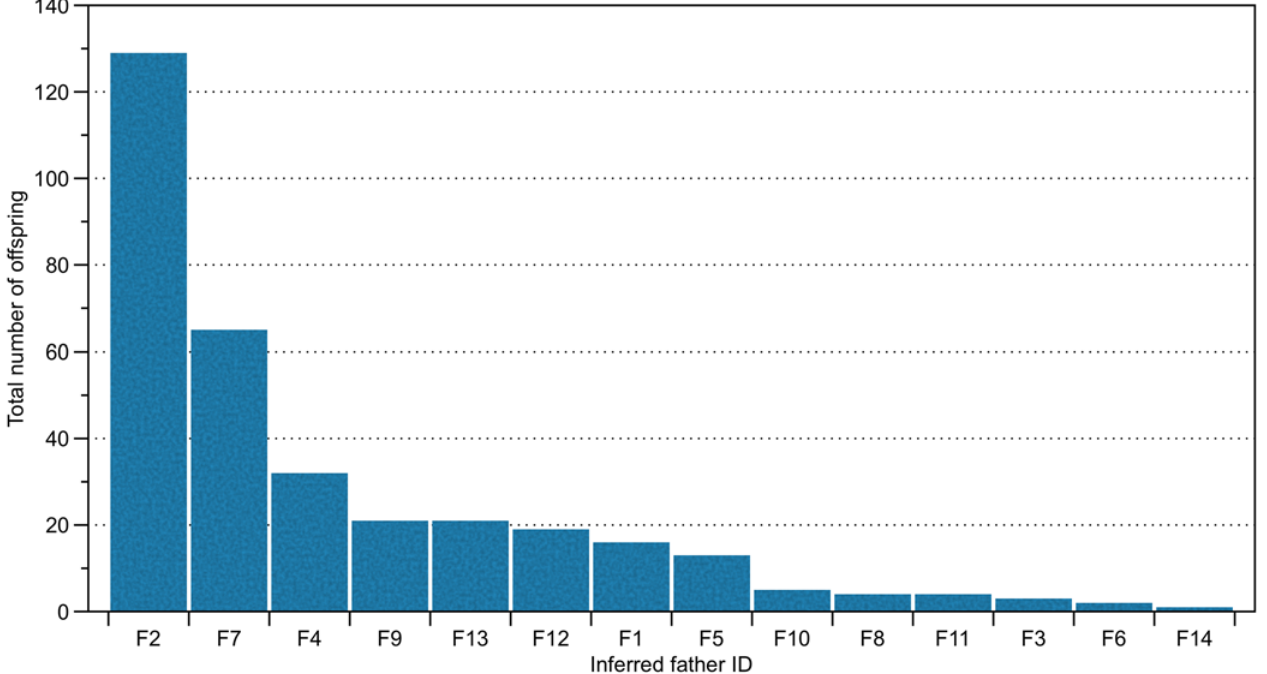
Fig 2. Paternal contributions from 14 fathers inferred by COLONY for 335 hatchlings of Crocodylus intermedius .